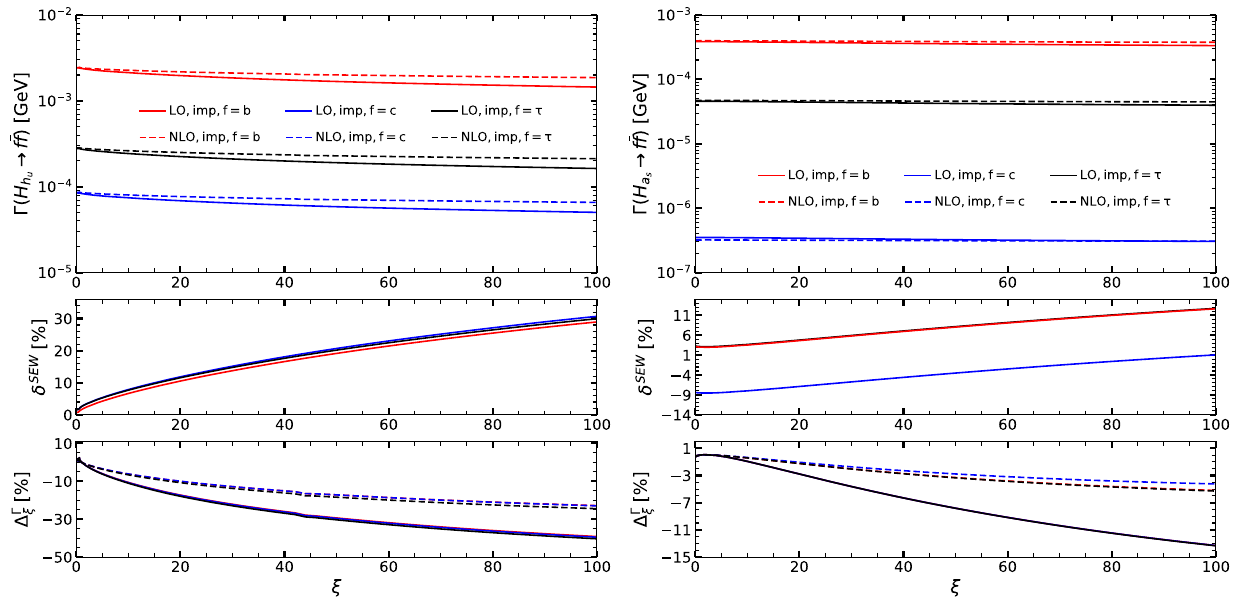
Fig. 17 Similar to the right-hand side of Fig. 16, but for the SM-like Higgs boson H h (left) and for the CP-odd singlet-like Higgs boson H a u (right). In the lower left plot, the blue and red lines are hidden under the